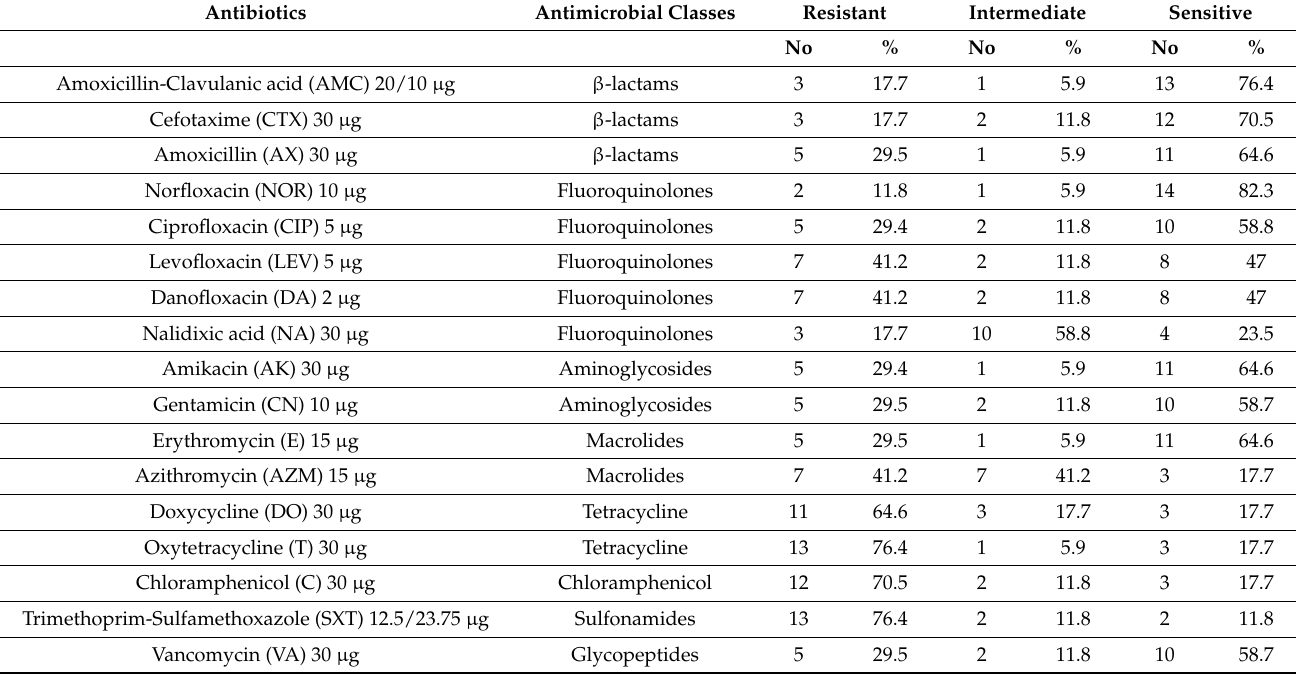
Table 3. Antimicrobial resistance profiles of L. monocytogenes isolates from food products.